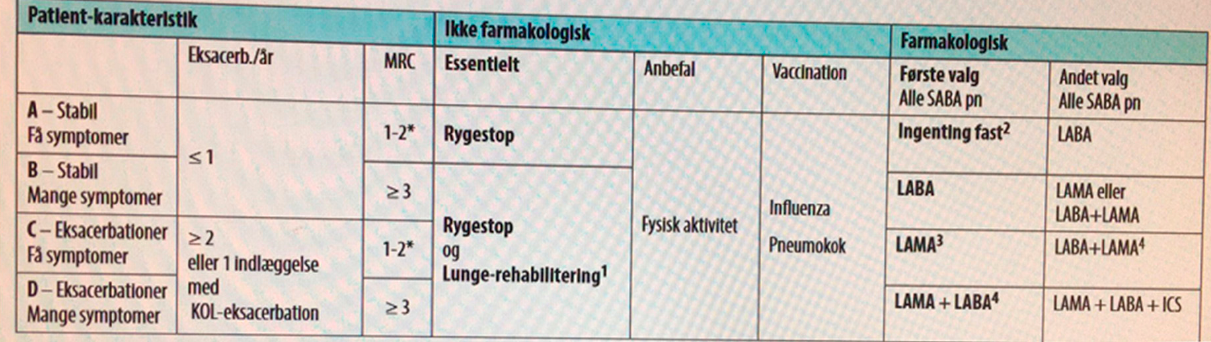
Figure 4. COPD gold standards A, B, C, and D encased in plastic—symptoms and exacerbations.